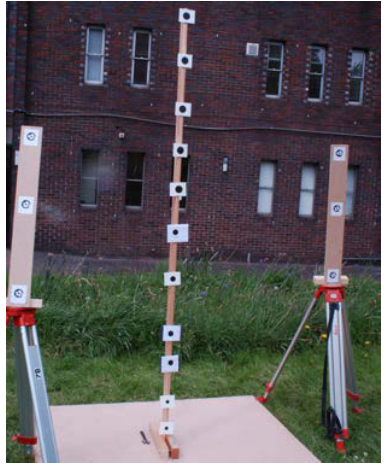
Figure 7. Timber upright outdoor model.